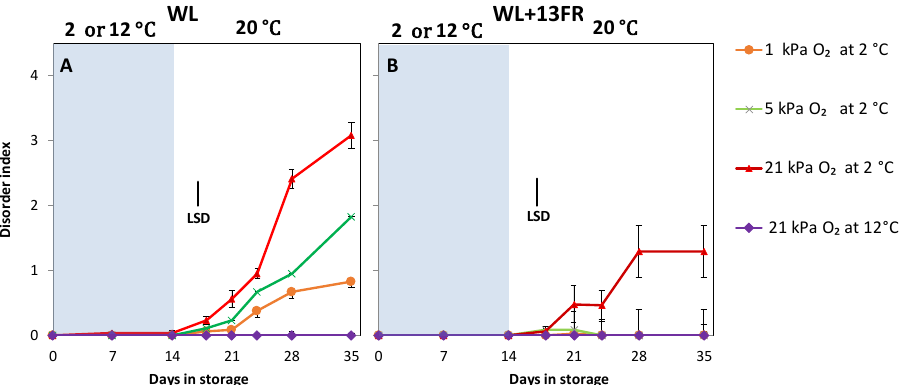
Figure 5. Chilling injury symptoms as indicated by the disorder index of MG tomatoes cultivated under white LED light (WL) without far red lighting ( A ) or with far red lighting during cultivation ( B ) during storage (blue area) at 2 or 12 °C and shelf-life at 20 °C (white area). Orange, green, red and purple lines and symbols indicate 1, 5 and 21 kPa O 2 (low oxygen control) applied during storage at 2 °C, and 21 kPa O 2 at 12 °C (temperature control), respectively. The average disorder index with indicated standard error is shown for two replicates of four tomatoes ( n = 2); (repeated measure over times). LSD values ( p < 0.05) are indicated per panel.